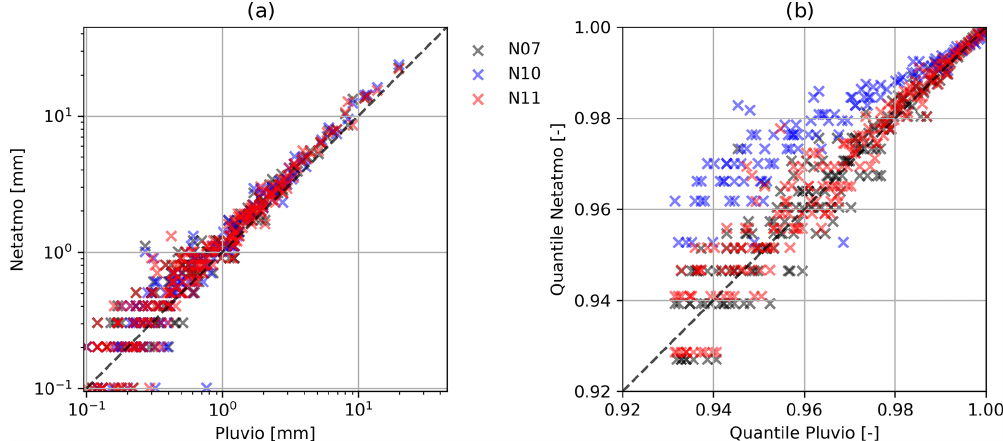
Figure 4. Scatter plot showing (a) the hourly rainfall values (axes log scaled) and (b) the corresponding upper percentiles > 0.92 (b) between the Pluvio 2 weighing gauge and three Netatmo gauges (N07, N10 and N11) at the IWS meteorological station.